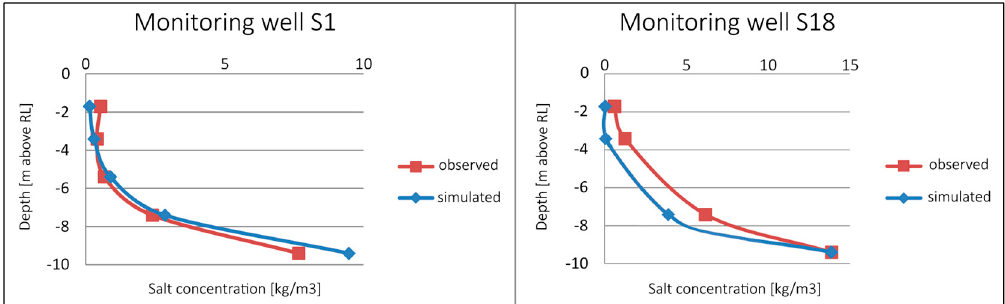
Figure 10. Observed vs simulated concentration values in monitoring wells S1 and S18. Table 3. Statistical results of the salt concentrations (kg/m 3 ) calibrated with the 2D density-dependent model.